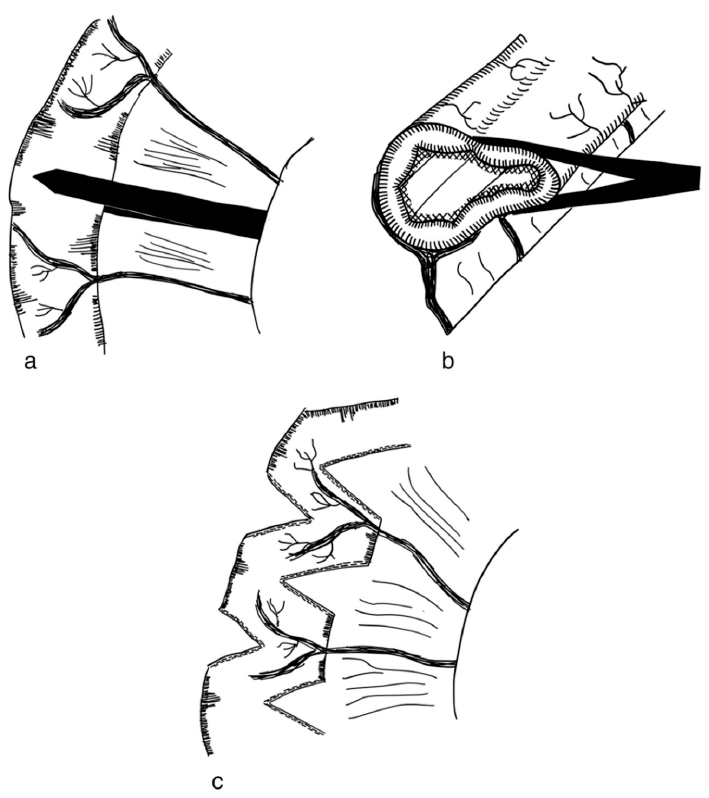
Figure 2. ( a ) With alternating cuts along the small intestine using a stapler ( b ) without damaging the mesentery ( c ), a zig-zag pattern is achieved, increasing the length of the small intestine. Kim et al.